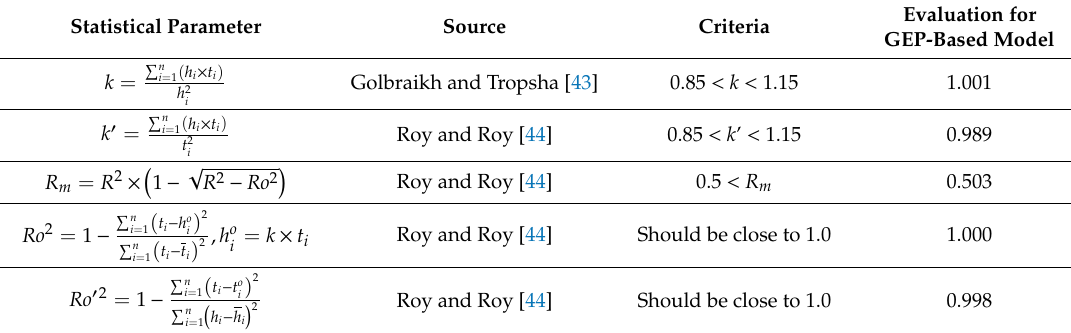
Table 4. Evaluating the developed GEP-based model using additional statistical parameters.